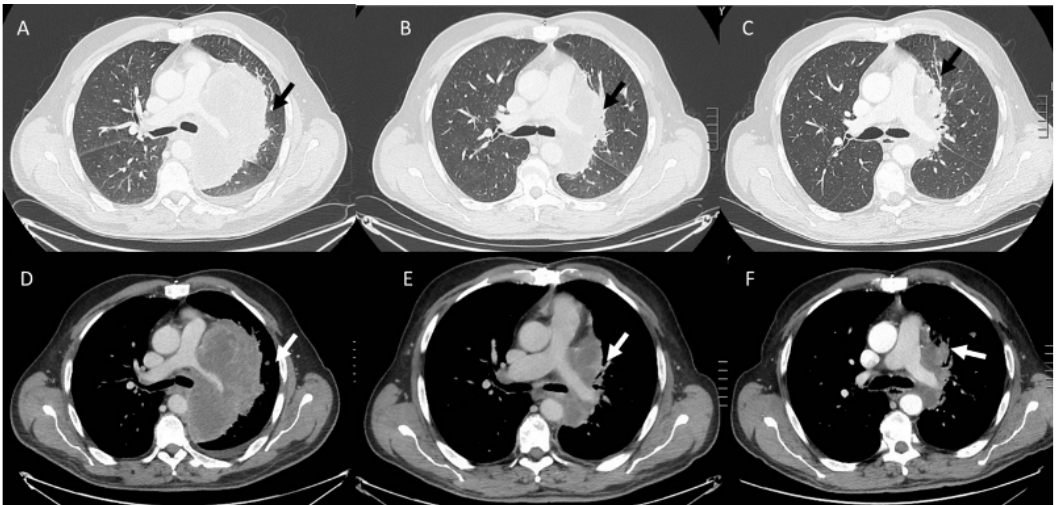
Diagnostics 2023 , 13 , x FOR PEER REVIEW Figure 2. Partial response pattern in non small lung cancer (NSLC) treated with immunotherapy (arrows). CT scan assessment in pre-treatment phase ( A ) and ( D ), at 3 months ( B ) and ( E ), and after 6 months ( C ) and ( F ).